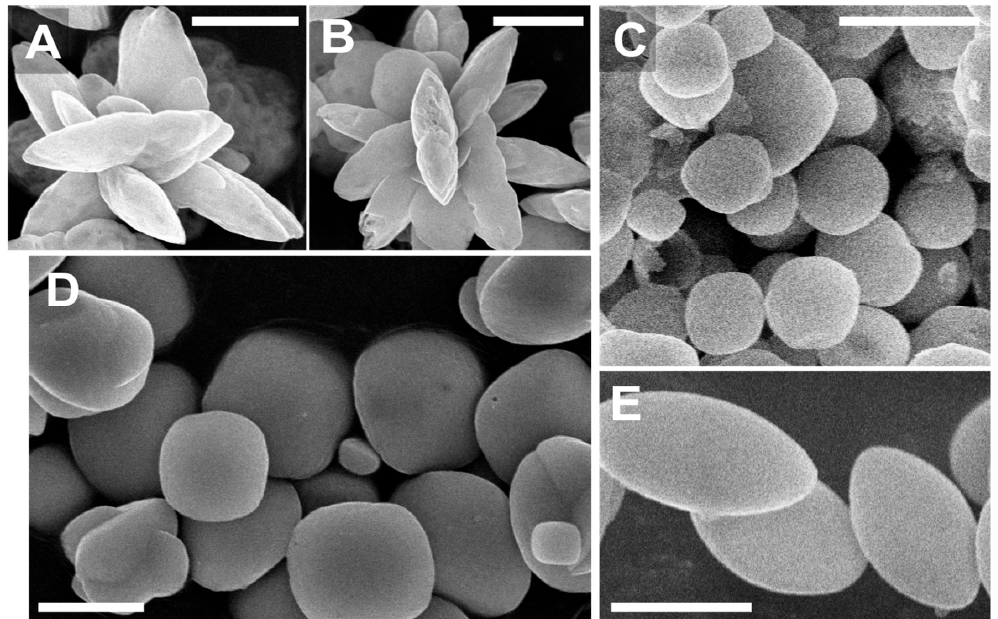
Figure 1. Scanning electron micrographs (SEM) of distinct crystal morphologies of synthetic barite. The scales on the images are 2 µ m. ( A , B ) Rosette crystals resulting from experiment 4a, performed at 5 ◦ C with a Sr/Ba ratio of 5; ( C ) well-rounded crystals resulting from experiment 3a, performed at 20 ◦ C with a Sr/Ba ratio of 15; ( D ) euhedral crystals precipitated in experiment 5a, performed at 40 ◦ C with a Sr/Ba ratio of 15; ( E ) elliptical crystals precipitated in experiment 4i, performed at 5 ◦ C with a Sr/Ba ratio of 5 with added organic compound sodium formate. Minerals 2018 , 8 , x